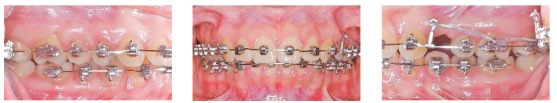
Intraoral photographs of the patient shown in Figures 12 and 13, with 0.016 x 0.022-in S.S. wires inserted. Retraction was performed with sliding mechanics.